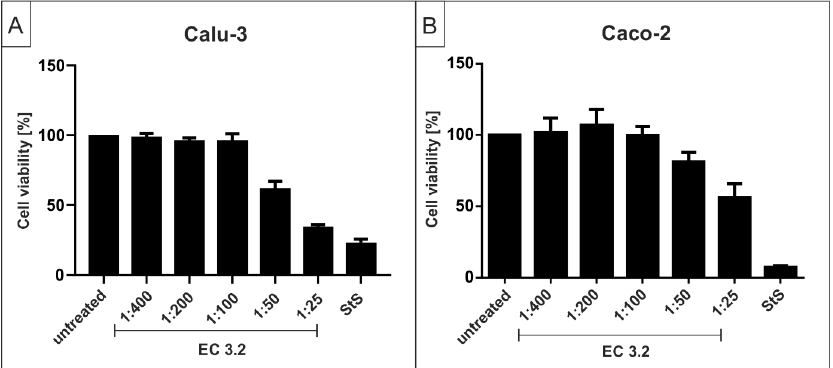
Figure 4. Influence of EC 3.2 on the cell viability of Calu-3 ( A ) and Caco-2 cells ( B ). Following treatment with different dilutions of EC 3.2 (indicated at the x-axis) for three days, the influence on cell viability was measured by water-soluble tetrazolium salt (WST)-1 assay. Bars represent means of 3 independent experiments ± SD. Staurosprine (StS, 1 μ M) was used as a positive control.